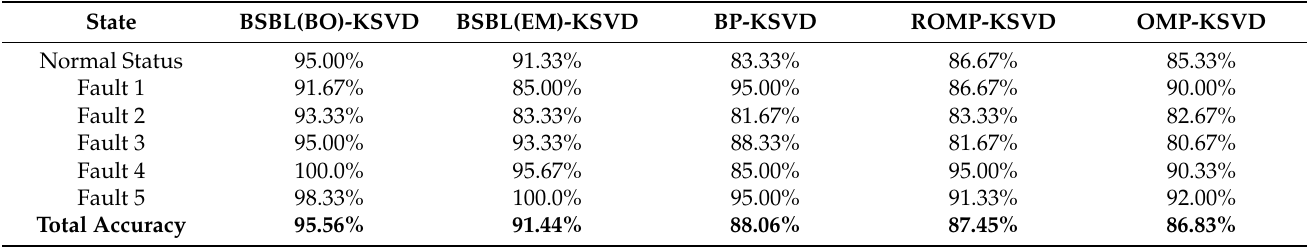
Table 3. When CR = 0.25, the comparative analysis of fault classification of different compression and reconstruction